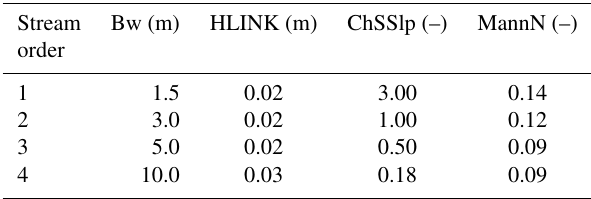
Table 2. WRF-Hydro channel parameter values used in this study (Bw is the channel bottom width, HLINK is the initial depth of water in the channel, ChSSlp is the channel side slope and MannN is the Manning’s roughness